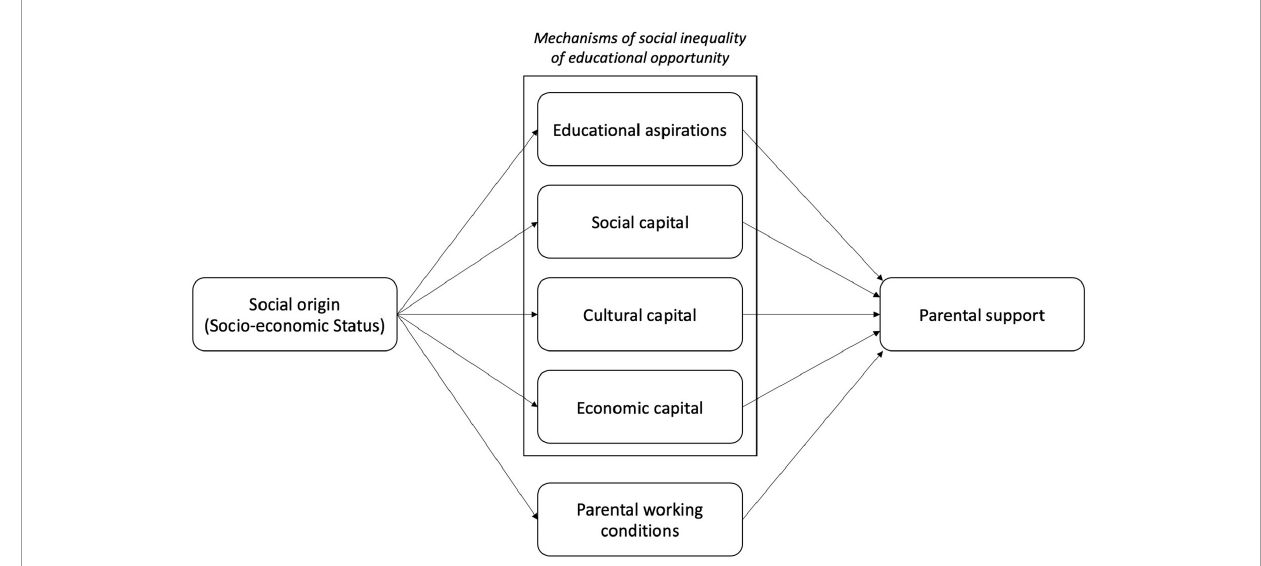
FIGURE1 Mechanisms of social inequality of parental support during homeschooling. Own illustration.